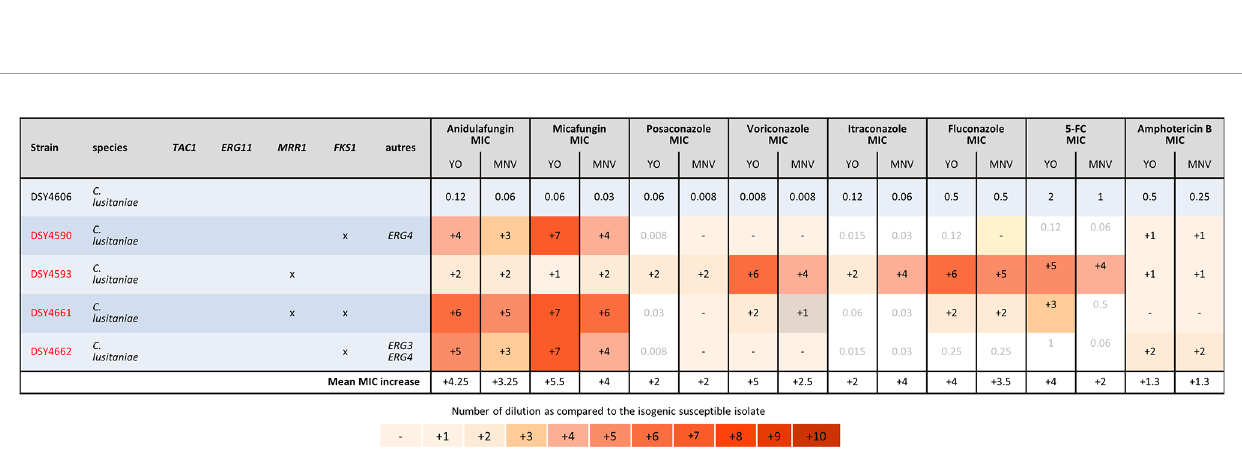
FIGURE 4 | Candin MIC increases of C. albicans and C . glabrata resistant strains as compared to matched susceptible ones for YO and MNV. (A) C. albicans matched strains. (B) C. glabrata matched strains. For all susceptible isolates, the MIC values are indicated in micrograms per millilliter of drugs, whereas for the matched resistant isolates, the respective number of azole dilutions to reach the MIC is indicated. When possible, the interpretation of the MIC, relative to existing breakpoints, is indicated in the YOI (for YO) and MNVI (for Micronaut-AM)